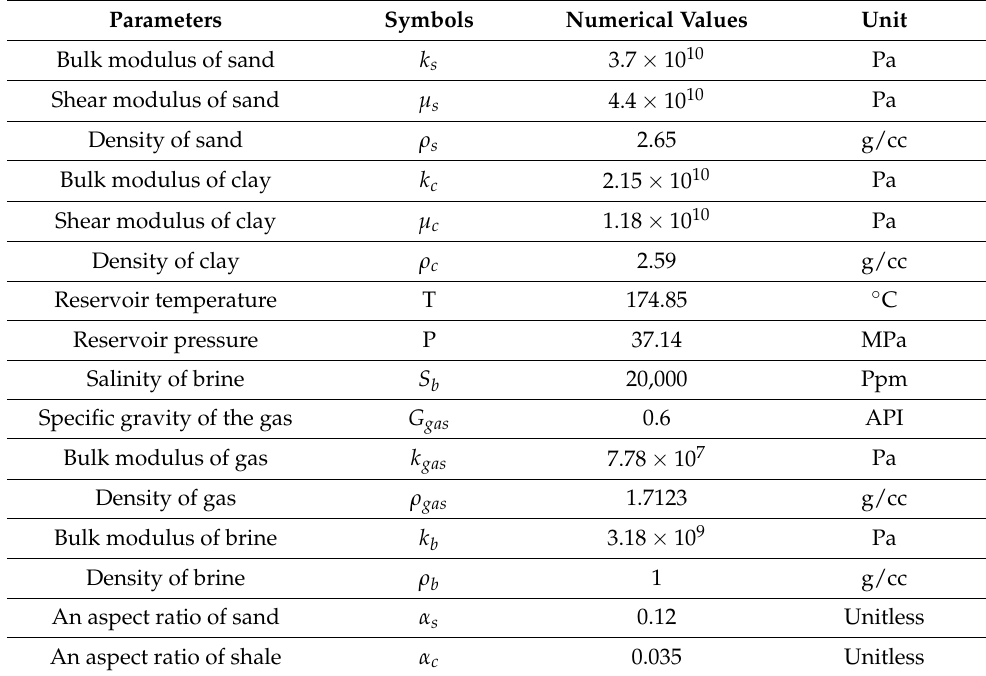
Table 3. Reservoir parameters for RPT